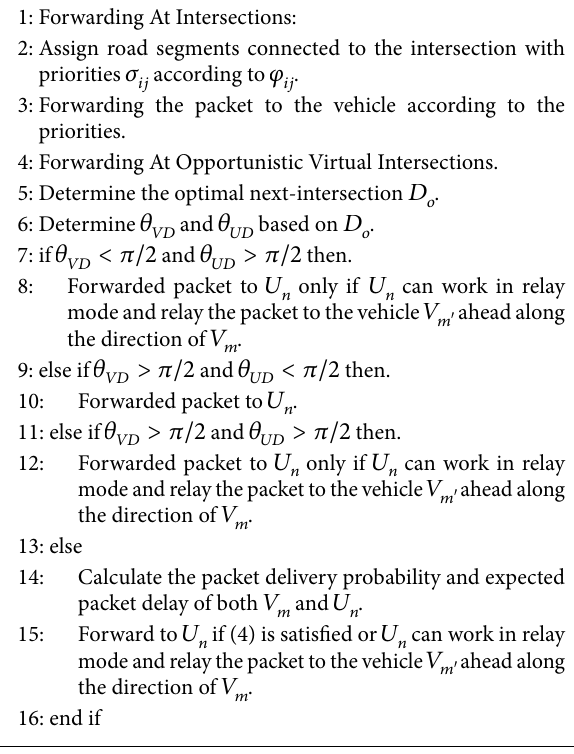
Algorithm 1: UADD Packet Forwarding Algorithm.